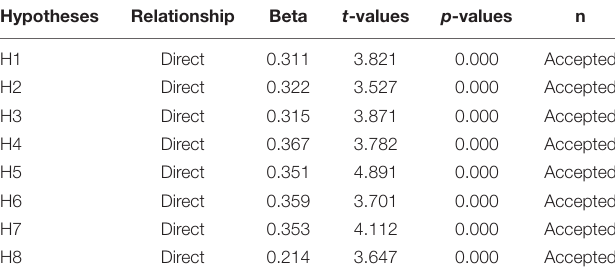
TABLE 5 | Standardized path